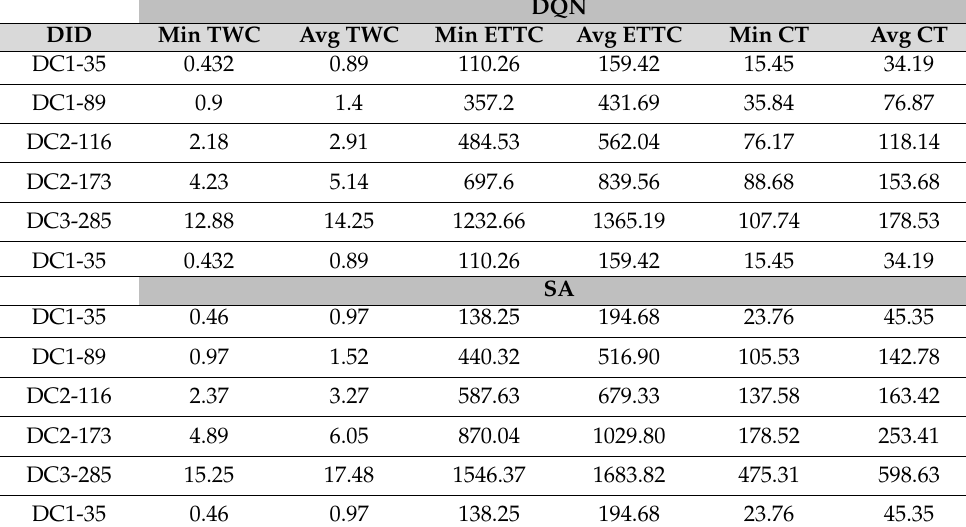
Table 9. Performance comparison between DQN and SA.